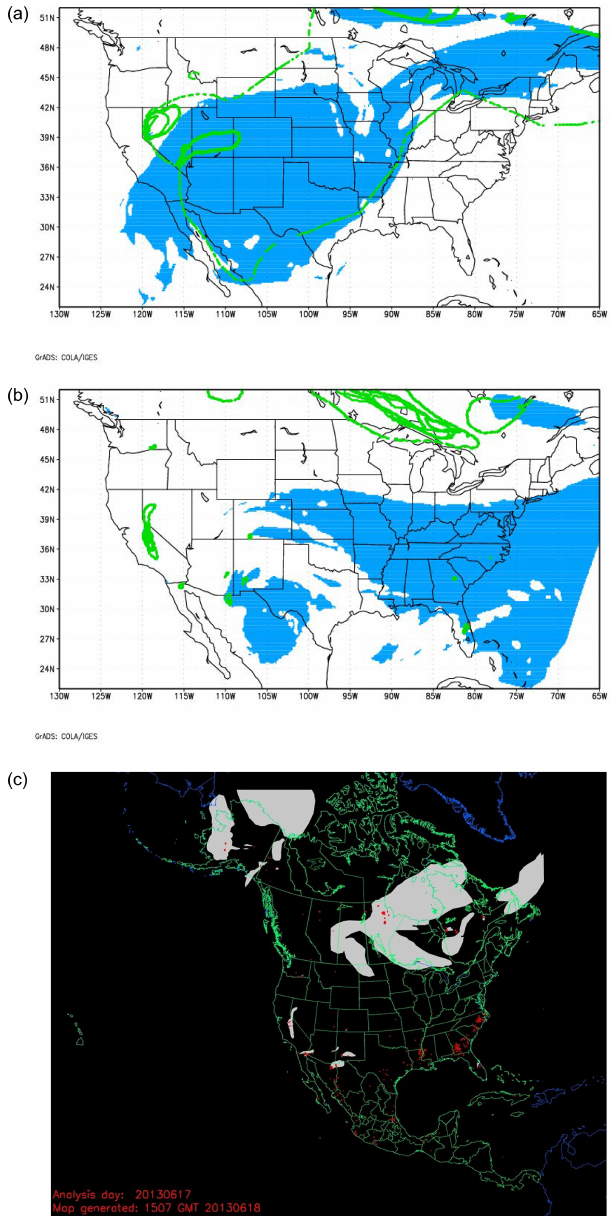
Figure 6. Daily HMS-observed plume shape versus CMAQ- predicted daily averaged plume shape on (a) 6 July 2013 and (b) 17 June 2013. The light blue shading represents modeled plume shape (defined as total column (cid:49) CO), and the thin dashed line and bold green lines encircle areas representing HMS-derived lightly and strongly influenced plume shape, respectively. (c) HMS- observed fire hotspots (red) and plume shapes (white) (http:// ready.arl.noaa.gov/data/archives/fires/national/arcweb, last